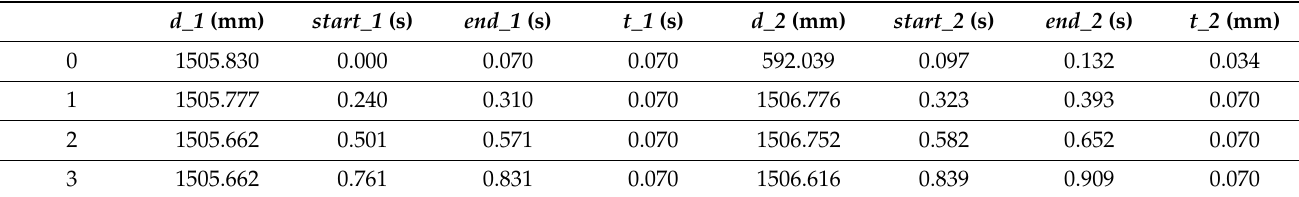
Table 4. Ultrasonic sensor data